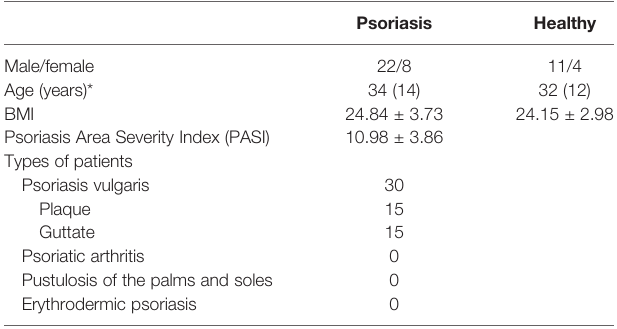
TABLE 1 | Characteristics of the psoriasis patients and healthy